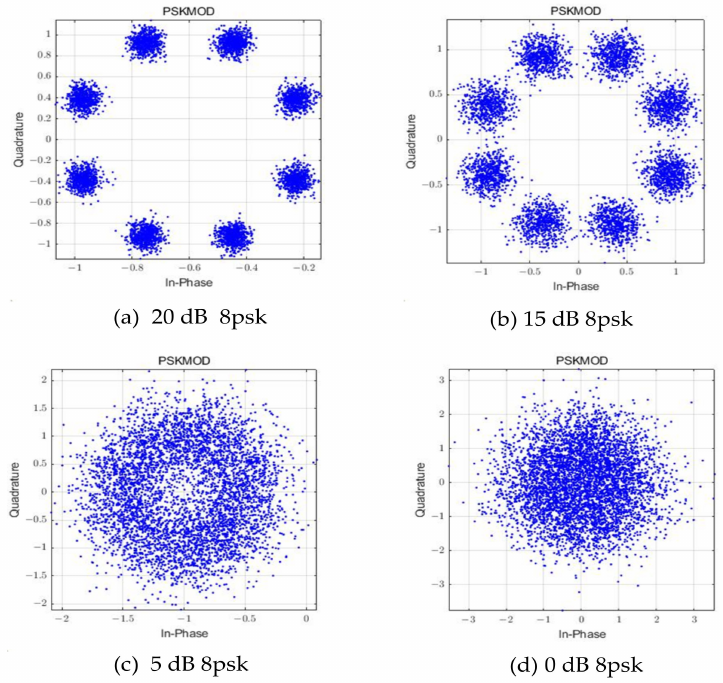
Figure 7. Constellation diagram of 8PSK under different signal-to-noise